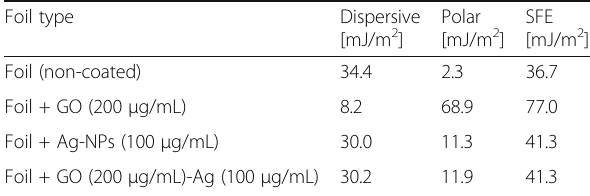
Table 4 Surface free energy of coated samples Foil type